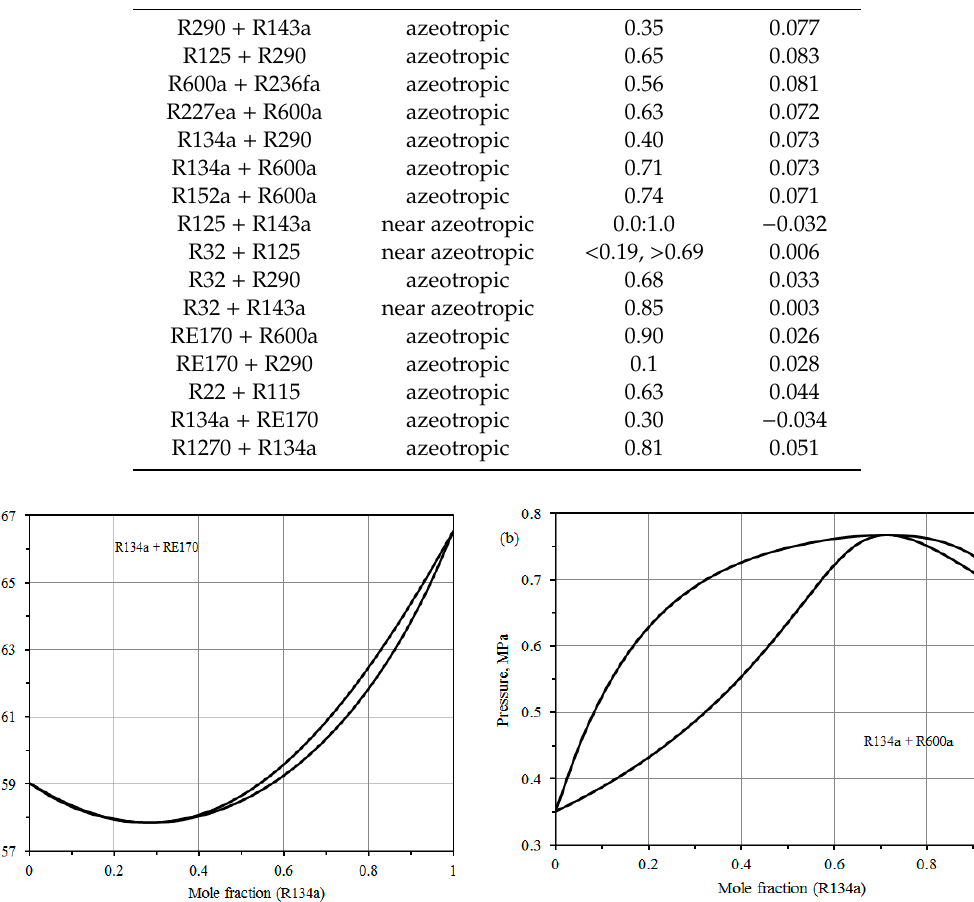
Figure 3. Pressure-concentration diagrams for; negative azeotrope ( a ), and positive azeotrope ( b